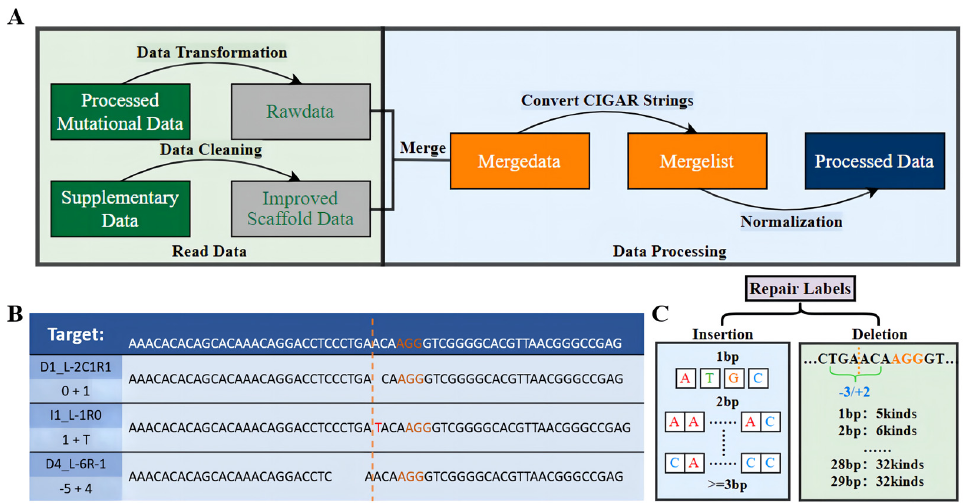
Figure 1. Overview of data preprocessing. ( A ) Data preprocessing process from left to right. ( B ) Example of conversion of CIGAR strings. The yellow dashed line indicates the cut site, the yellow font represents the PAM, the top is the DNA sequence of the editing target, and the bottom is the repair labels corresponding to the three mutational outcomes. ( C ) The 557 repair labels, including insertions and deletions.